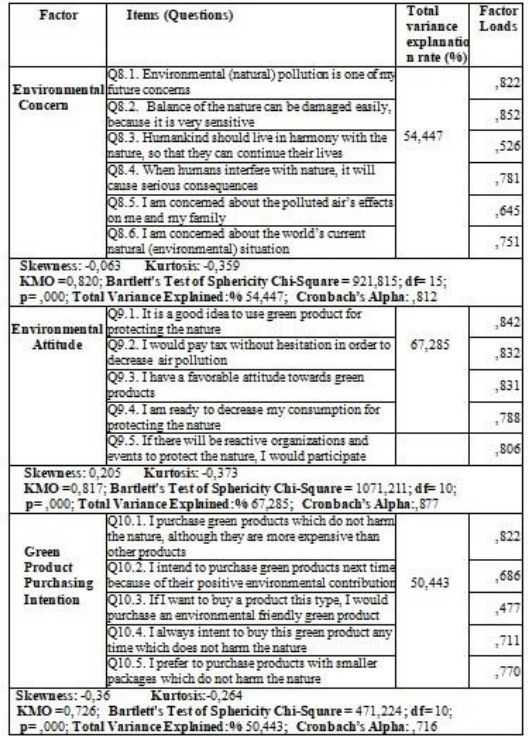
Table 2. Exploratory Factor Analysis